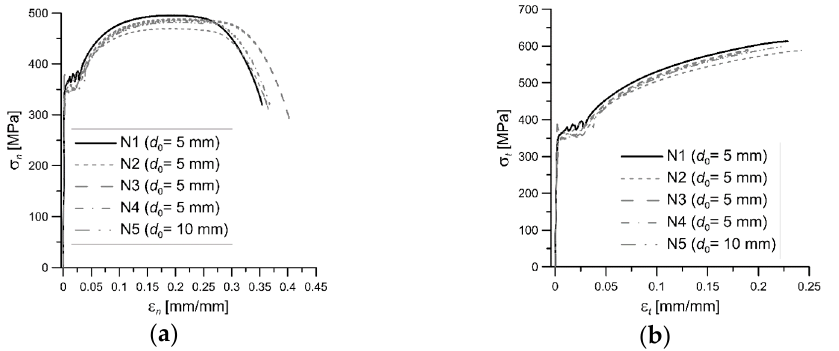
Figure 2. The stress-strain plots for specimens of S355 steel: ( a ) nominal values; ( b ) true values. The appropriate values of strength characteristics and plasticity obtained based on nominal and true data are present in Table 2. Table 2. The strength and plasticity properties of S355 steel. S355 Steel